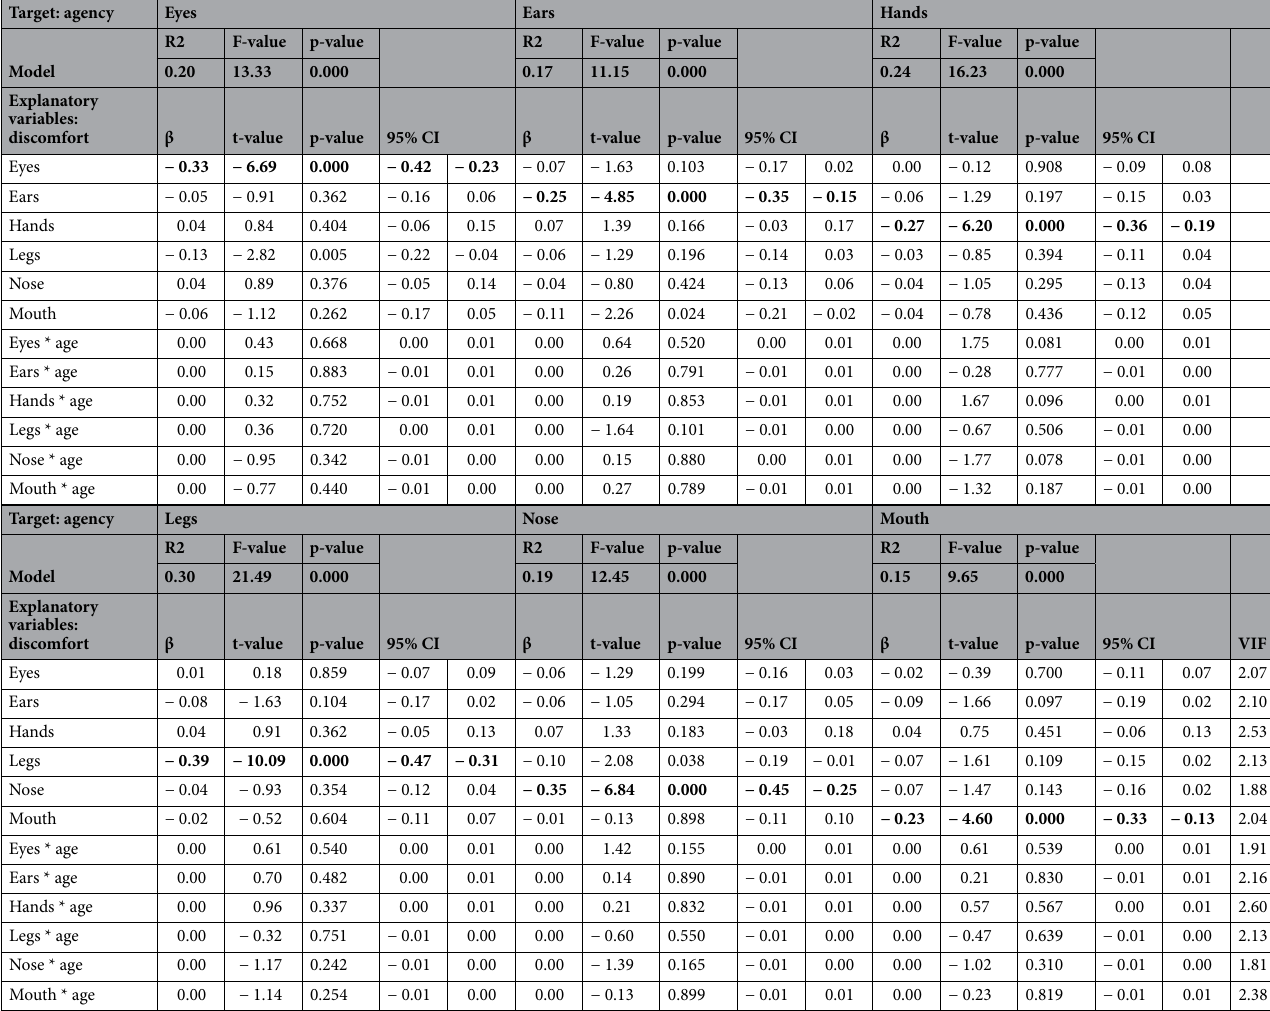
Table 4. Statistics of multiple regression analyses from the discomfort to agency sensation in each body part. Bold letters indicate significant beta